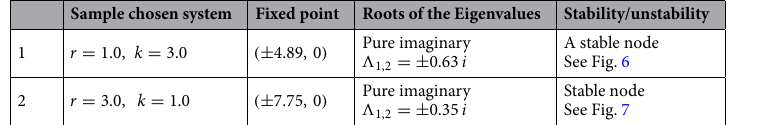
Sample chosen system Fixed point Roots of the Eigenvalues